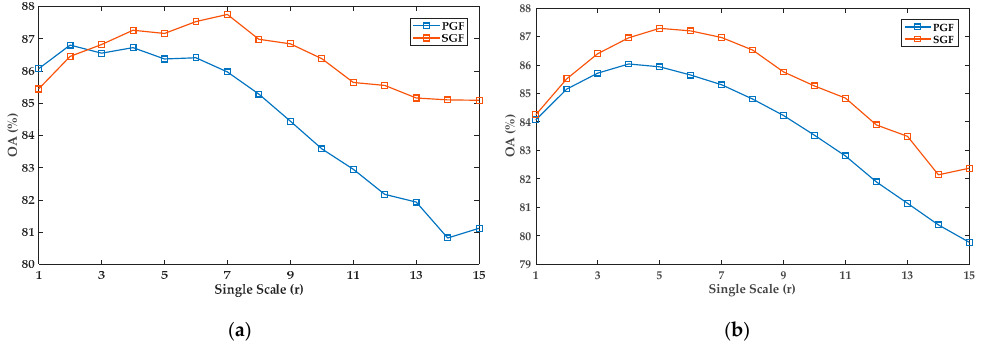
Figure 8. Single-scale classification performance comparison between the proposed SGF and the original PGF approaches obtained on: ( a ) Zh1 and ( b ) Zh2.